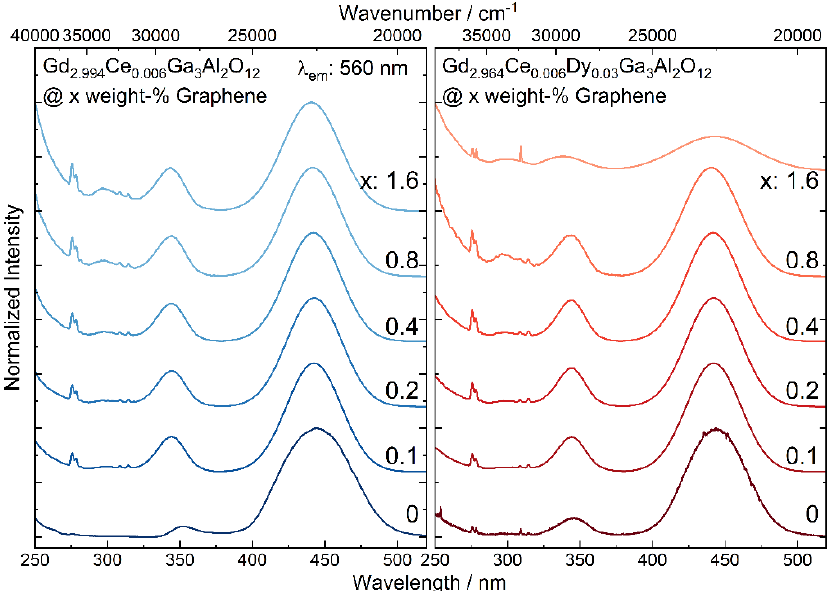
Figure 4. The excitation spectra of Gd 2.994 Ce 0.006 Ga 3 Al 2 O 12 and Gd 2.964 Ce 0.006 Dy 0.03 Ga 3 Al 2 O 12 ceramics with different graphene content. Table 1. Position of the 5d levels, their full width and half maximum (FWHM) and the distance between 5d1 and 5d2 states ( Δ 21 ) calculated from excitation spectra of Gd 2.994 Ce 0.006 Ga 3 Al 2 O 12 and